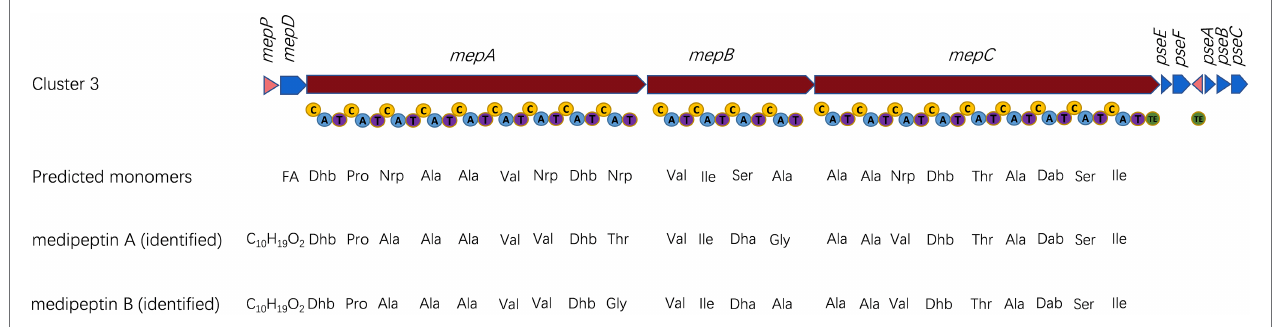
FIGURE 3 | Characterization of biosynthetic gene cluster (BGC) of medipeptins. Transporter genes are indicated in blue; core biosynthetic genes are shown in red; and regulator genes are labeled in pink. Three core biosynthetic genes ( mepA-C ) contain 22 modules including adenylation (A), condensation (C), thiolation (T) and thioesterase (TE) domains. The predicted amino acids sequences are compared with identified medipeptins below. FA, fatty acid; and Nrp, uncertain amino